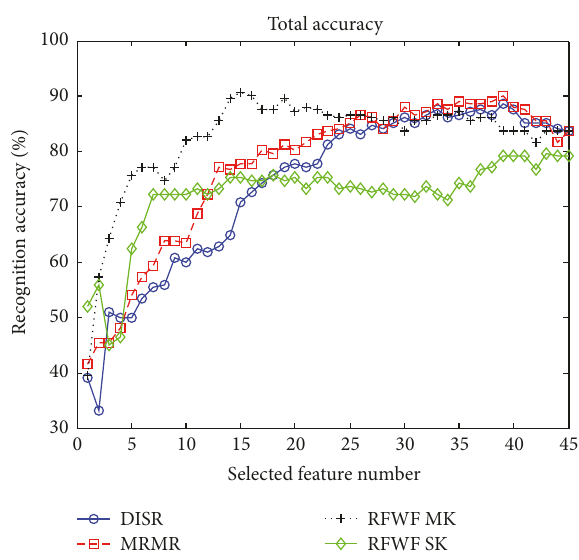
Figure 3: Emotional recognition